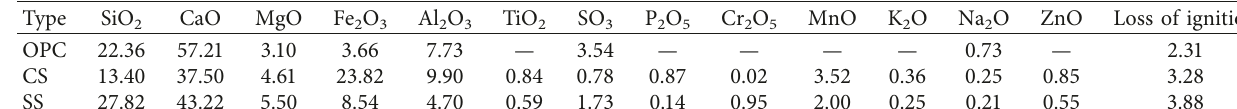
Table 1: The chemical composition of CS and SS.